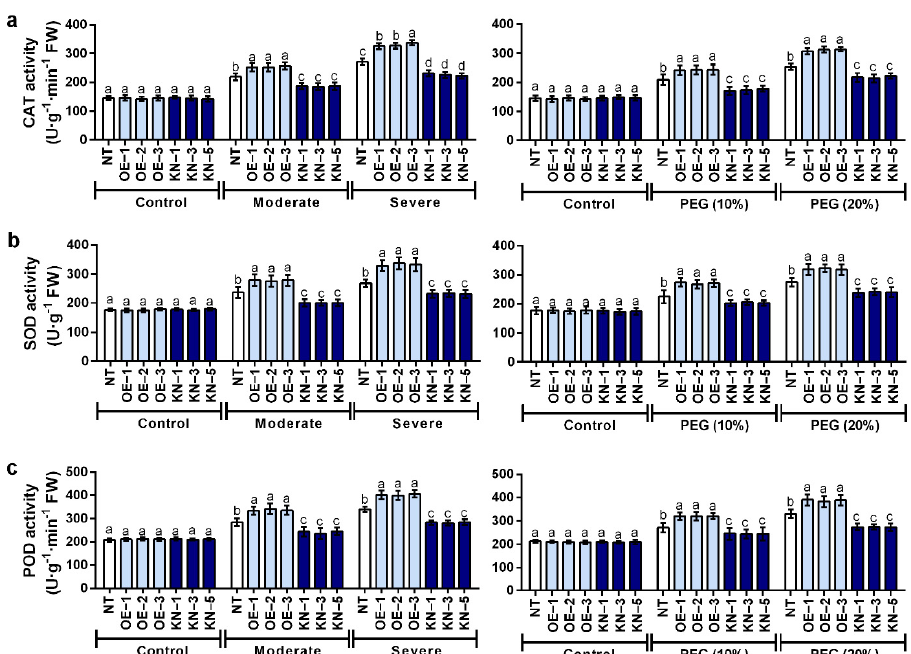
Figure 6. Upregulation of StCDPK28 counteracts the effects of water deficiency and PEG stress on the contents of H 2 O 2 , MDA and proline. Contents of ( a ) H 2 O 2 , ( b ) MDA, and ( c ) proline were detected 24 h after water deficiency and PEG treatment. Data are presented as the means ± standard deviation of nine replicates. The letters indicate significant difference according to one-way ANOVA corrected by Dunnett ( p < 0.05).